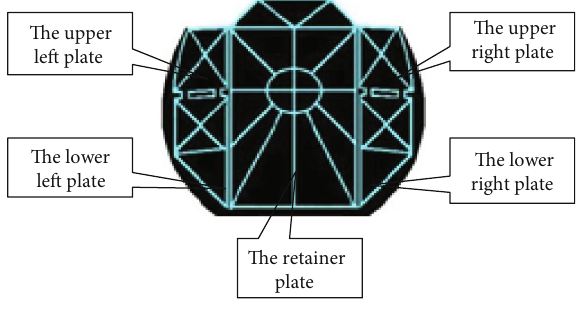
Figure 1: Deployable antenna panel.